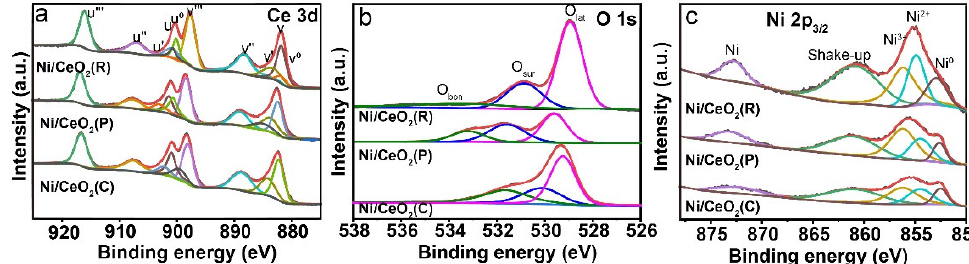
Figure 3. XPS ( a ) Ce 3d, ( b ) O 1s, and ( c ) Ni 2p 3/2 spectra of Ni/CeO 2 (R), Ni/CeO 2 (P), and Ni/CeO 2 (C) catalytic materials. (u, u’’, u’’’ represent the peak of Ce 4+ 3d 3/2 ; v, v’’, v’’’ represent the peak of Ce 4+ 3d 5/2 ; u 0 , u’ represent the peak of Ce 3+ 3d 3/2 ; v 0 , v’ represent the peak of Ce 3+ 3d 5/2 ; O bon, O sur, O lat stand for chemisorbed species or Ce 3+ surface defects on the surface, surface-adsorbed, and weakly bonded oxygen species and lattice oxygen, respectively.)